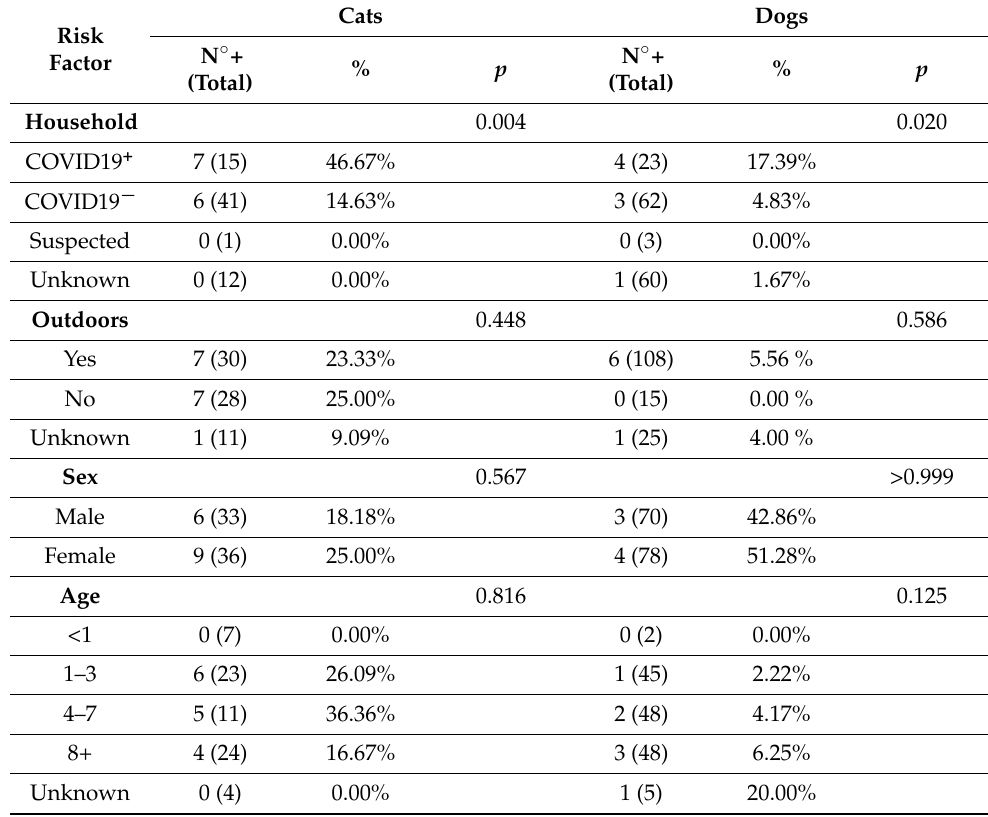
Table 2. Risk factors contributing to cats and dogs SARS-CoV-2